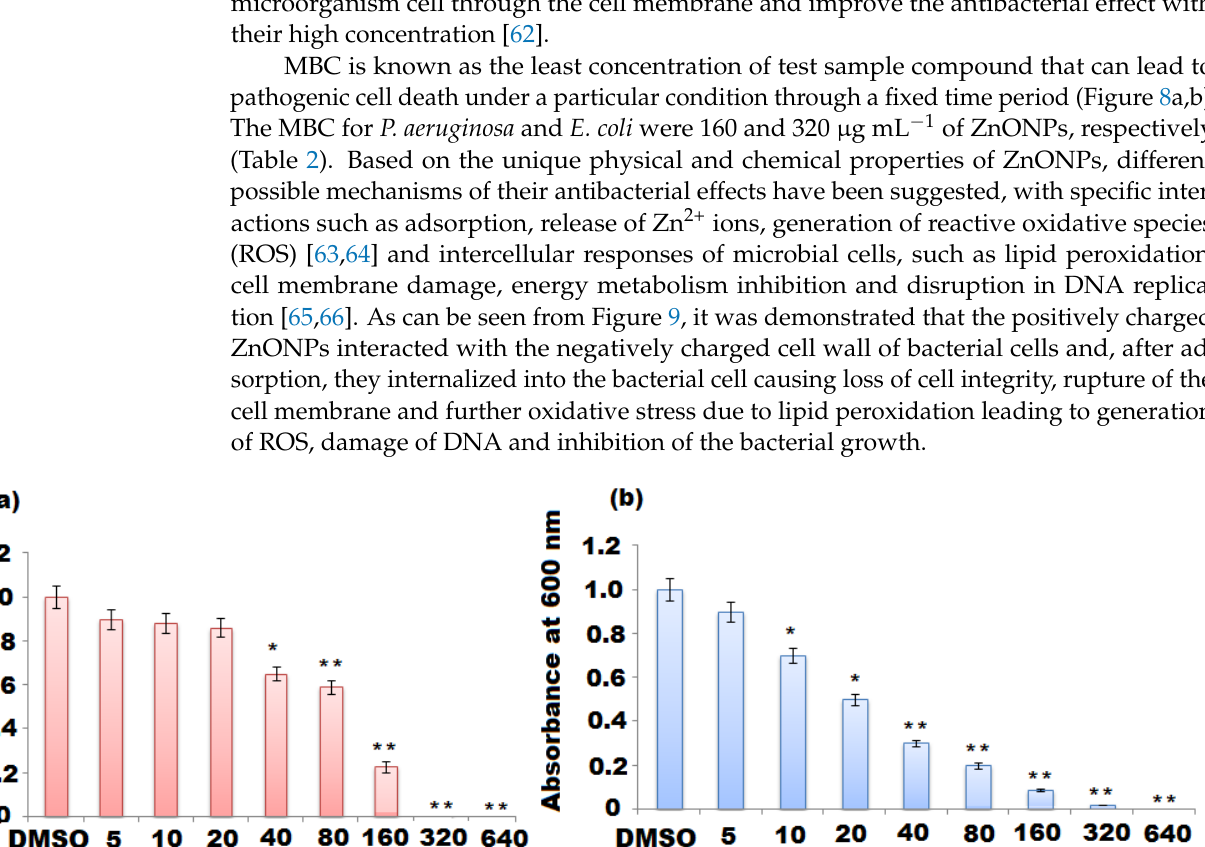
Figure 9. The possible mechanism of antibacterial effect of green synthesized ZnONPs using oat biomass against the bacterial cell. Table 2. Least bactericidal potential of ZnONPs synthesized using oat biomass on P. aeruginosa , E. coli, B. subtilis and S. aureus. Sample Concen- tration (µg mL − 1 )